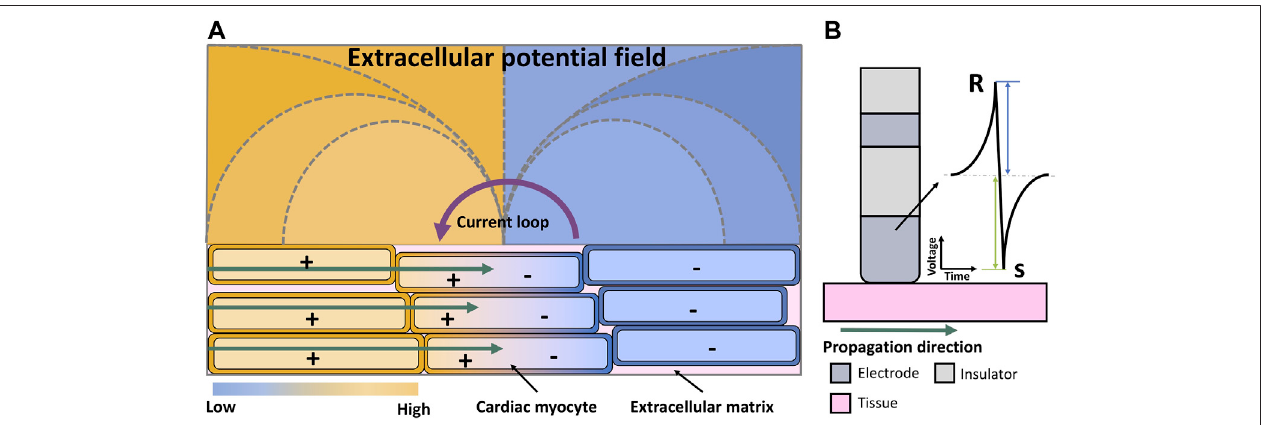
FIGURE 1 | Electrical propagation in healthy cardiac tissue. (A) Extracellular fi eld caused by the depolarization of cardiomyocytes when an excitation propagates fromlefttoright(greenarrows). (B) Symmetricunipolarelectrogrammeasuredatthesurfaceofthecardiactissue(pink).Theinitialpositivewave(R-peak)iscausedbythe wavefront approaching theelectrode(dark gray), thepolarity changeswhen thewavefront passesunderneath the electrode, and theS-peak iscaused bythewavefront traveling away from the measuring